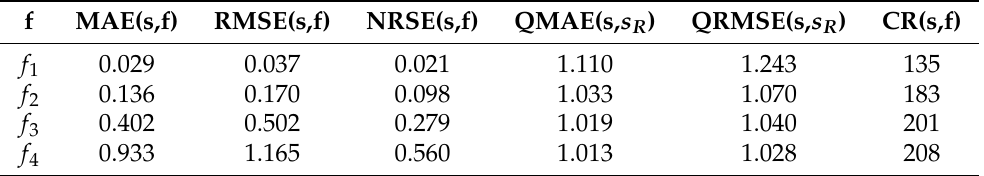
Table 1. Performance comparative analysis (see Section 5.1.2): cubic splinelet generated spline (denoted as s ) vs. smoothing spline (denoted as s R ) for all test streams f i , where i = 1,2,3,4.